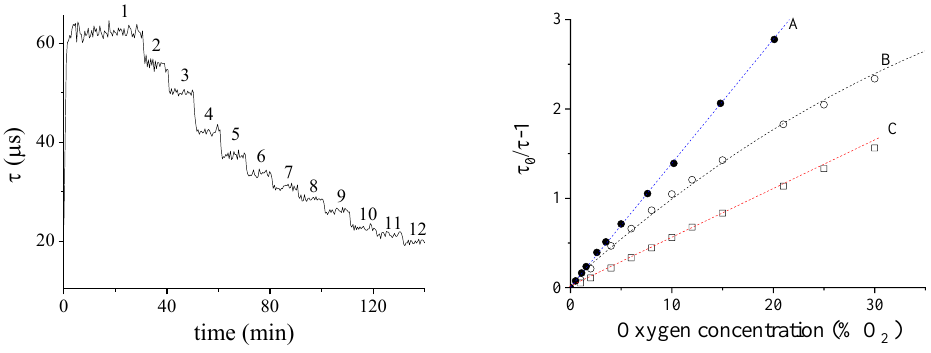
Figure 7. ( a ) Luminescence-lifetime of a PtTFPP/PSF membrane versus time, at various